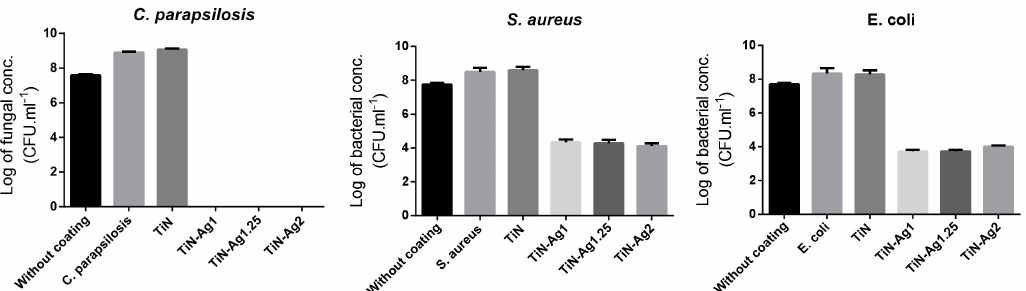
Figure 7. Logarithm of microbial concentration after 24 h contact between C. parapsilosis , S. aureus and E. coli and the different samples: TiN, TiN-Ag1, TiN-Ag1.25 and